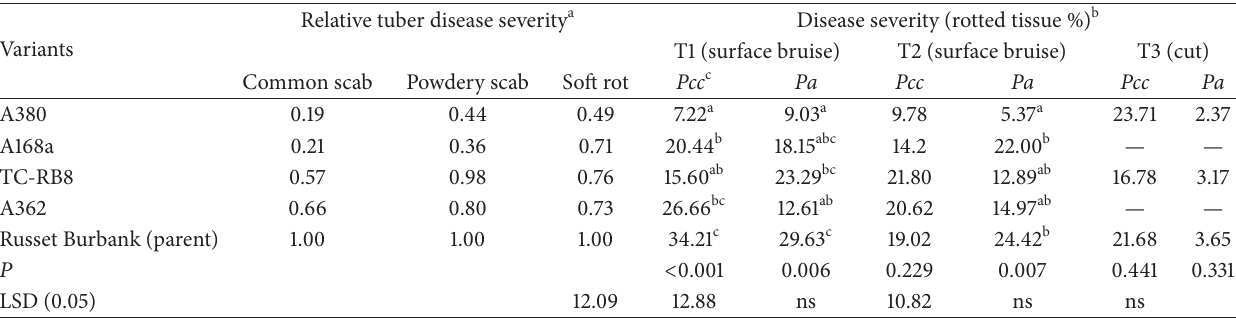
Table 1: Severity of tuber soft rot in selected potato cv. Russet Burbank variants. Tubers were tested against Pectobacterium carotovorum subsp. carotovorum (Pcc) and P. atrosepticum (Pa) using two different inoculation techniques (T1 and T2—surface bruise; T3—cut) with an incubation period of 14 days.